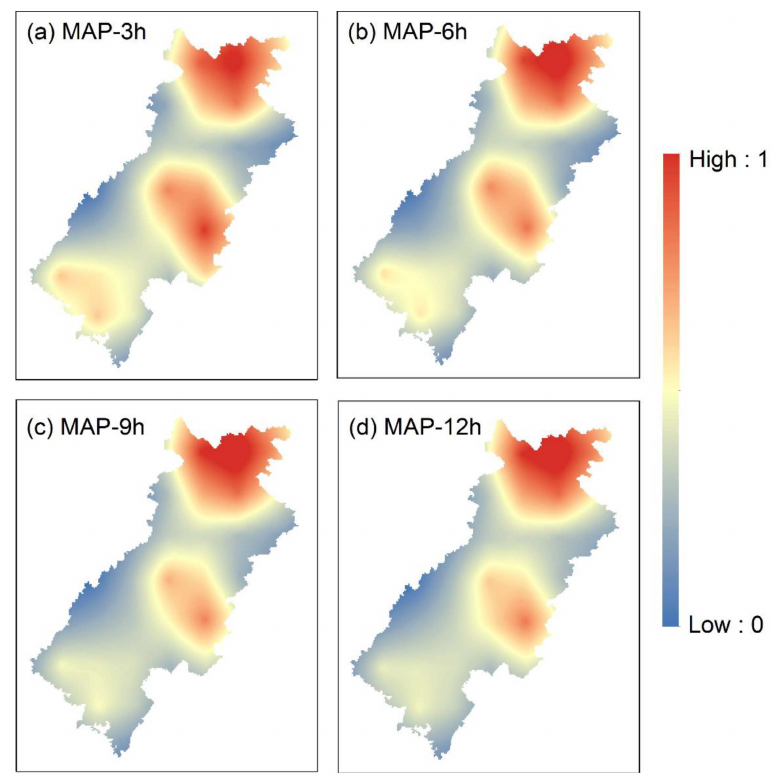
Figure 6. Spatial distribution of maximum precipitation (MAP) factor with four durations using the LR method. ( a ) MAP-3 h; ( b ) MAP-6 h; ( c ) MAP-9 h; ( d ) MAP-12